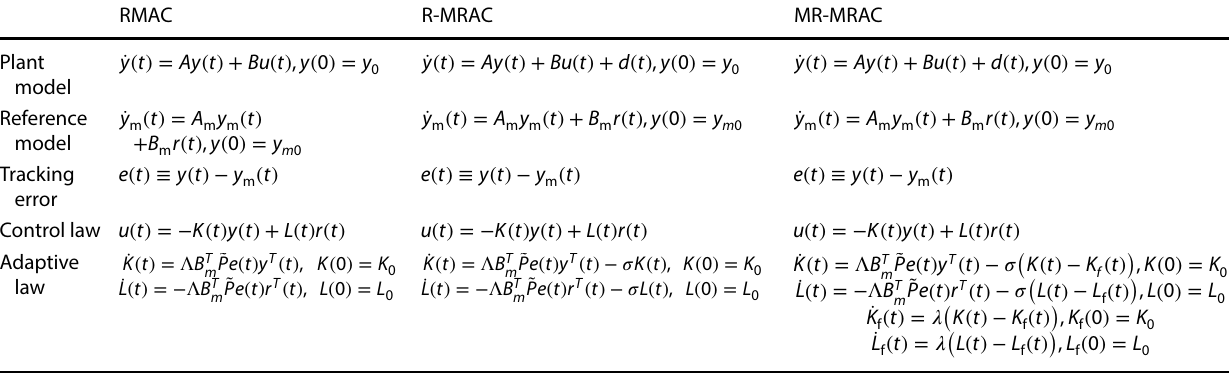
Table 1 Equations of the MRAC, the R-MRAC and the MR-MRAC schemes RMAC R-MRAC MR-MRAC Plant